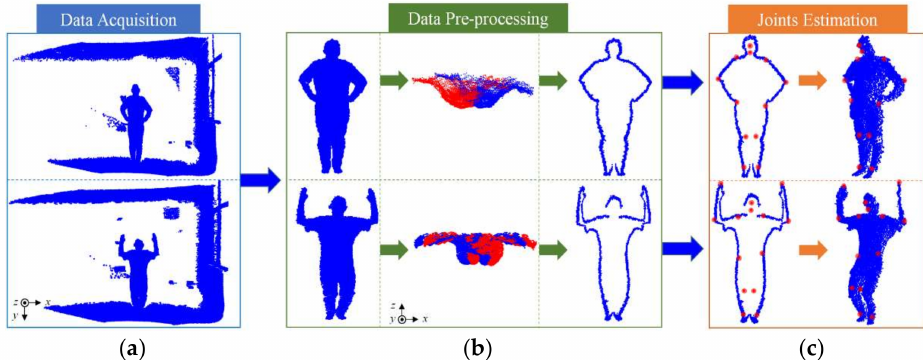
Figure 9. Geometric feature is used for human joint estimation. The approach consists of three stages: data acquisition, data pre-processing and joint estimation. ( a ) The point clouds are directly obtained from the depth camera. ( b ) Data pre-proposing mainly involves three parts: firstly, the irrelevant points are filtered, then the orientation of the human point cloud is adjusted, and finally the 3D silhouette is extracted. ( c ) Fourteen joints of human body are extracted by using the geometric feature of human silhouette. Figure from